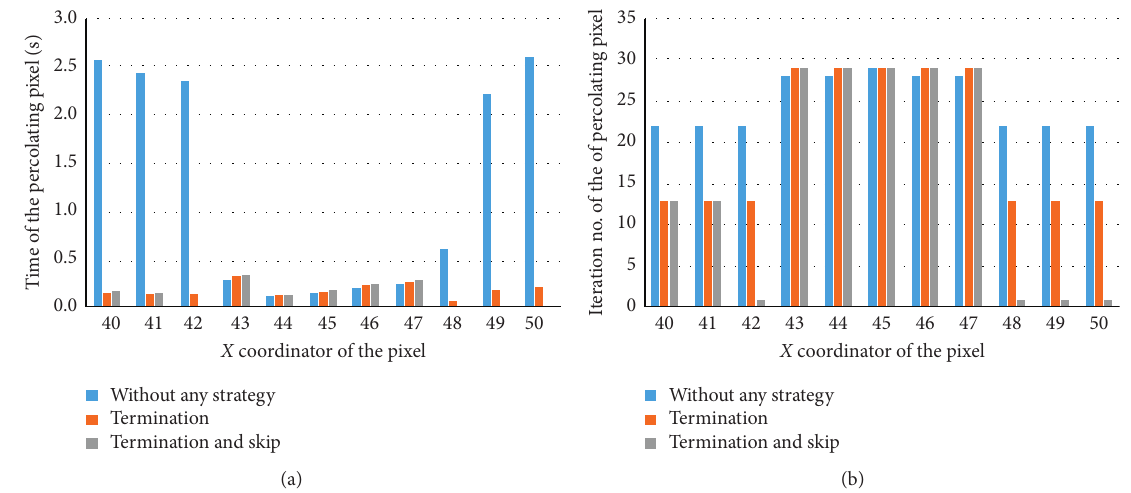
Figure 16: Results of the percolating single pixel using different speeding-up strategies: (a) percolation time; (b) percolation iterations.